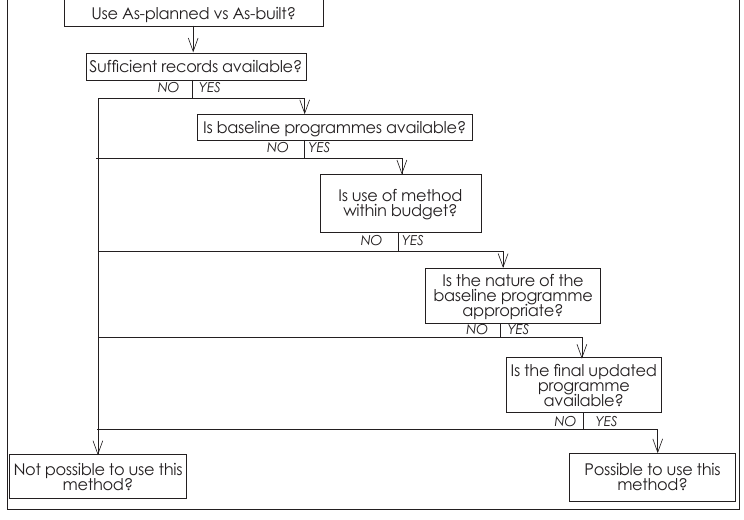
Figure 7: Decision tree: Use As-planned vs As-built?